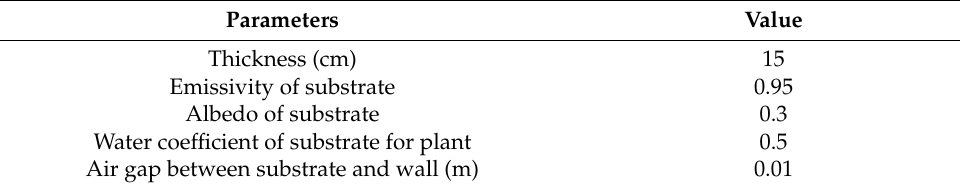
Table 2. Properties of Funkia (Hosta).